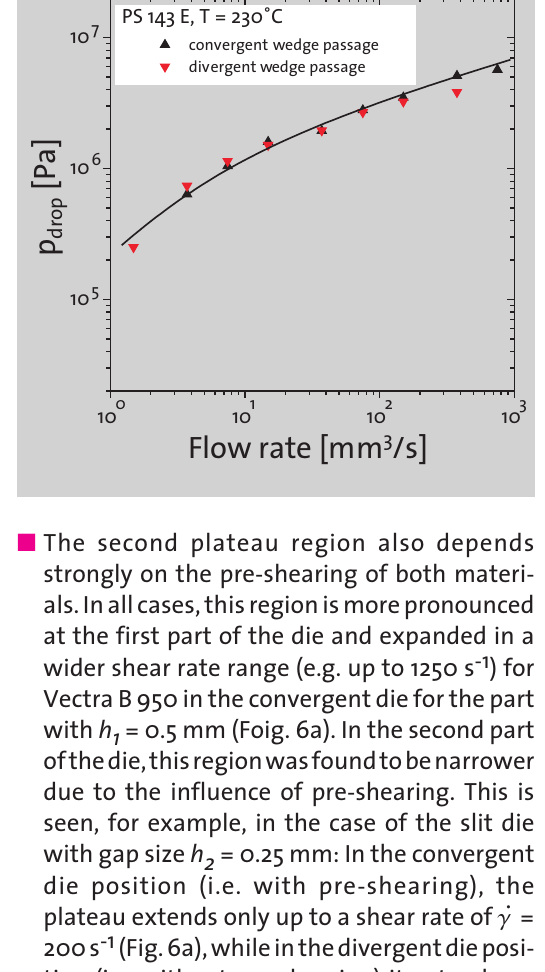
Figure 7 (left): Geometry invariant pressure drop in convergent and divergent wedge passage for a polystyrene melt with flexible chains. Figure 8 (right): Geometry dependent pressure drops in convergent and divergent wedge passage for LCP melts Vectra L 950 and Vectra B